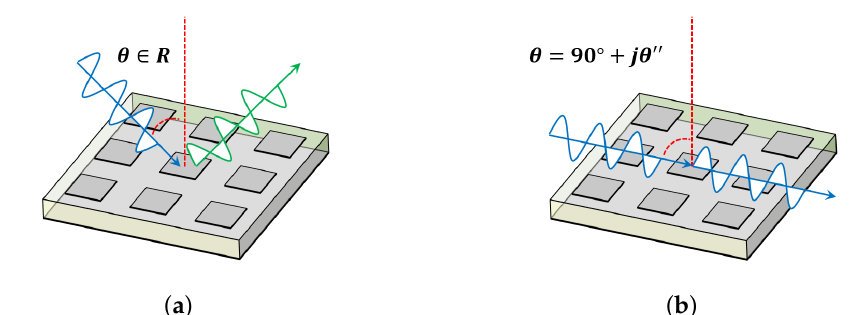
Figure 8. Electromagnetic surfaces ( a ) space-wave mode ( b ) surface-wave